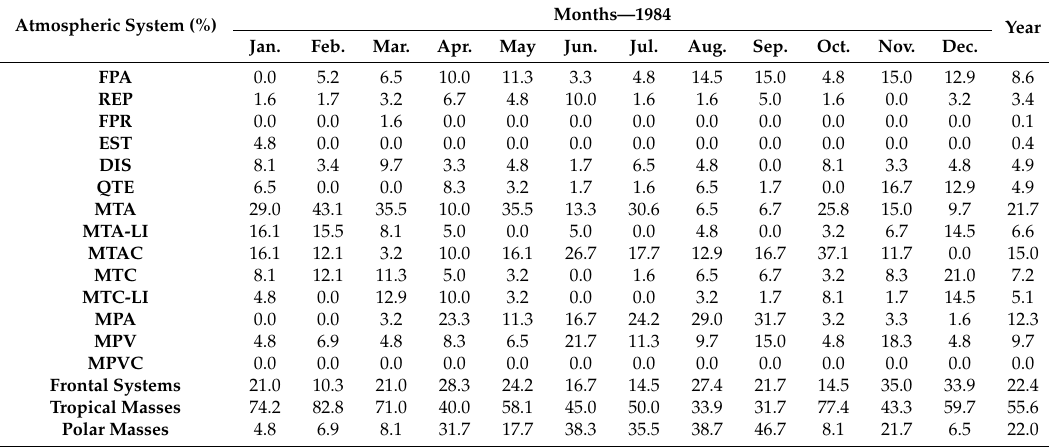
Table 5. Atmospheric systems frequency at the monthly level in the year